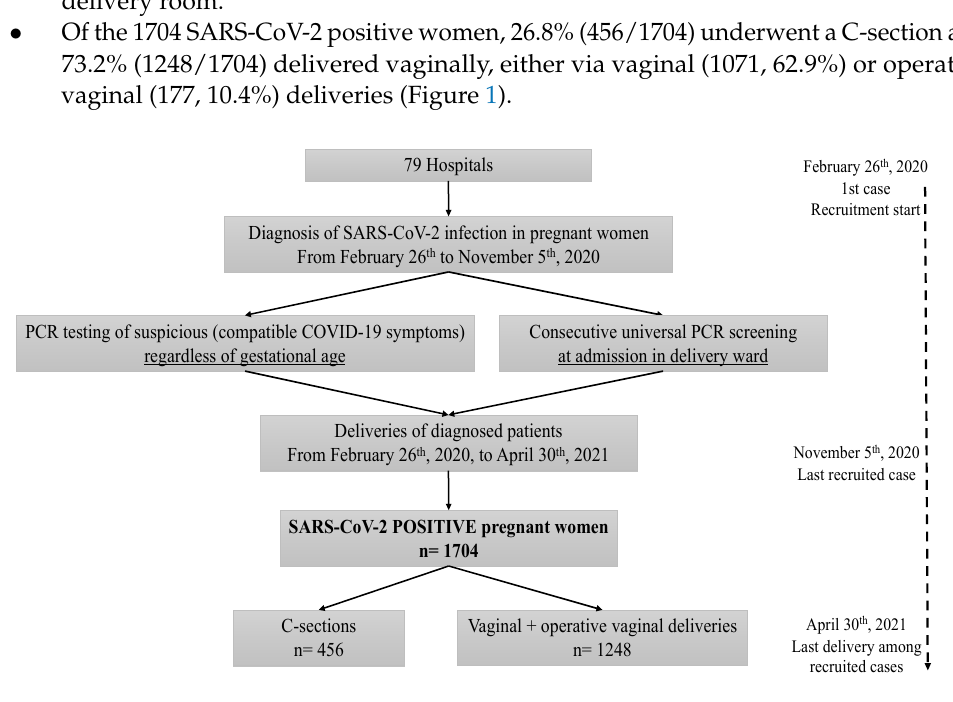
Figure 1. Flow chart of the study data.